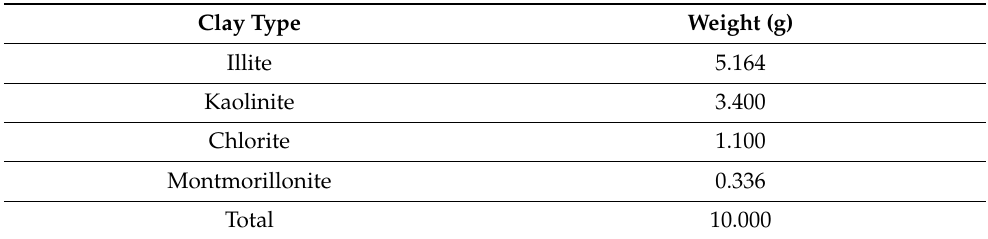
Table 4. Mineral composition of artificial clay samples